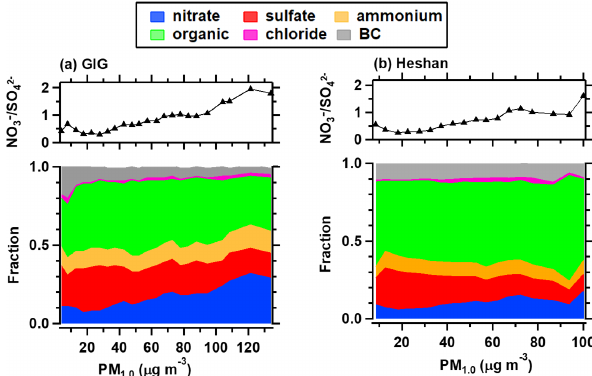
− / SO 2 − (top) and 3 4